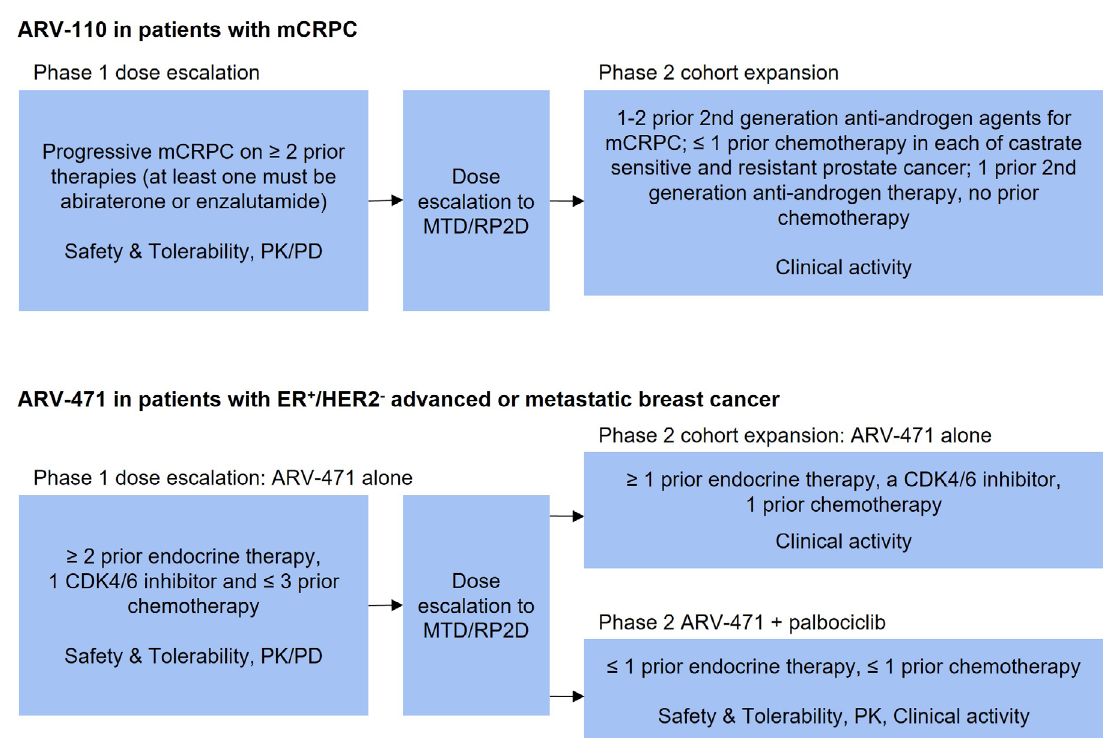
Figure 2. Design of selected clinical trials of PROTAC degraders. PK: pharmacokinetic; PD: pharmacodynamic; RP2D: recommended phase II dose; CDK4/6: cyclin dependent kinase